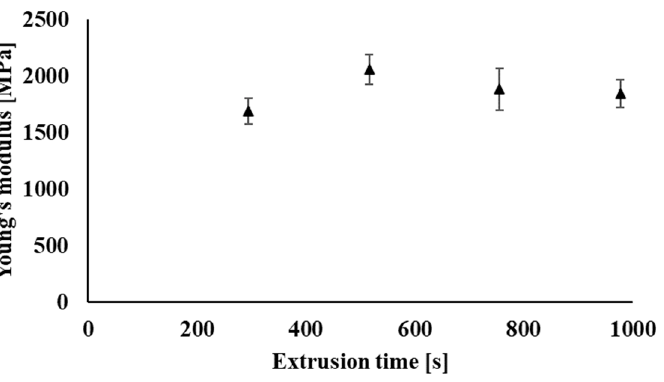
Figure 19. Dependence of flexural strength deformation on the total processing time of the material in the form of filaments processed under industrial.